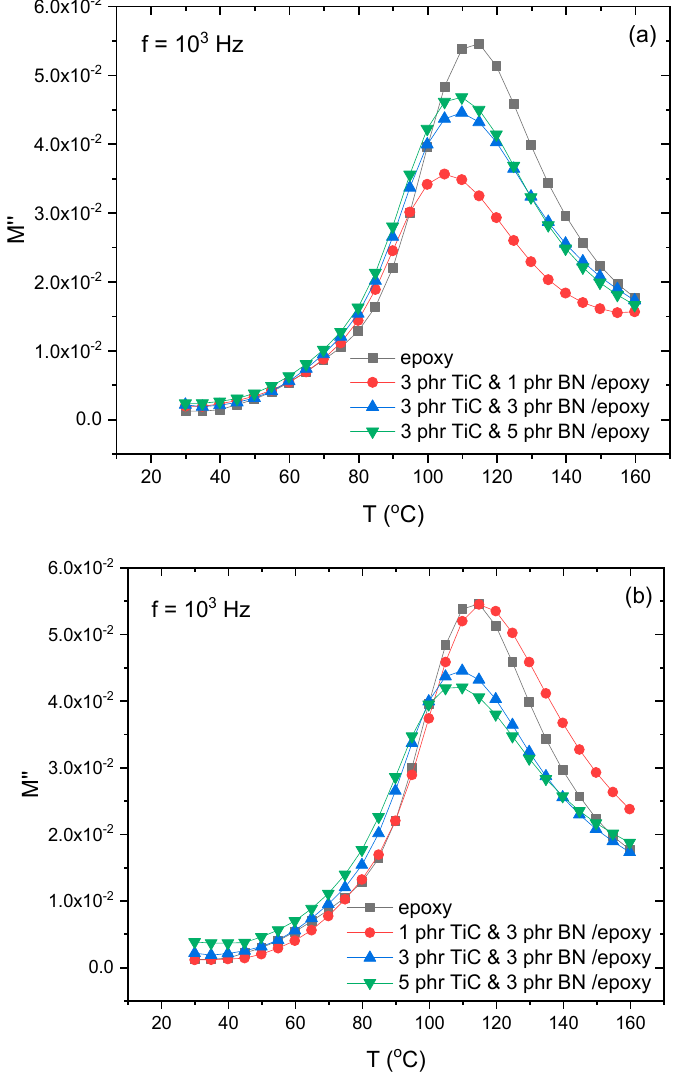
Figure 8. Imaginary part of electric modulus as a function of temperature, at 1 kHz, for the systems with: ( a ) 3 phr TiC, varying the BN content and ( b ) 3 phr BN, varying the TiC content.